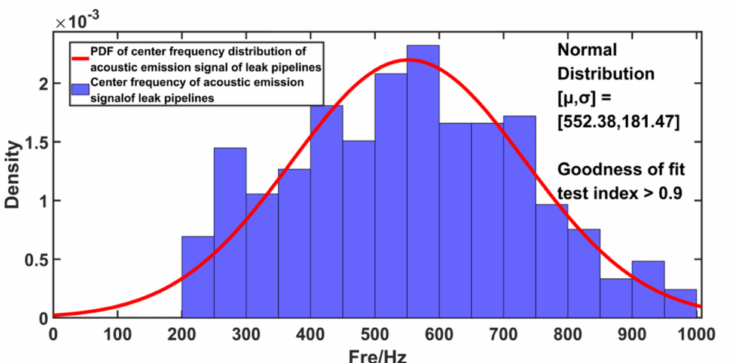
Figure 5. Distribution of the central frequencies of the acoustic signals of the water supply pipeline with a